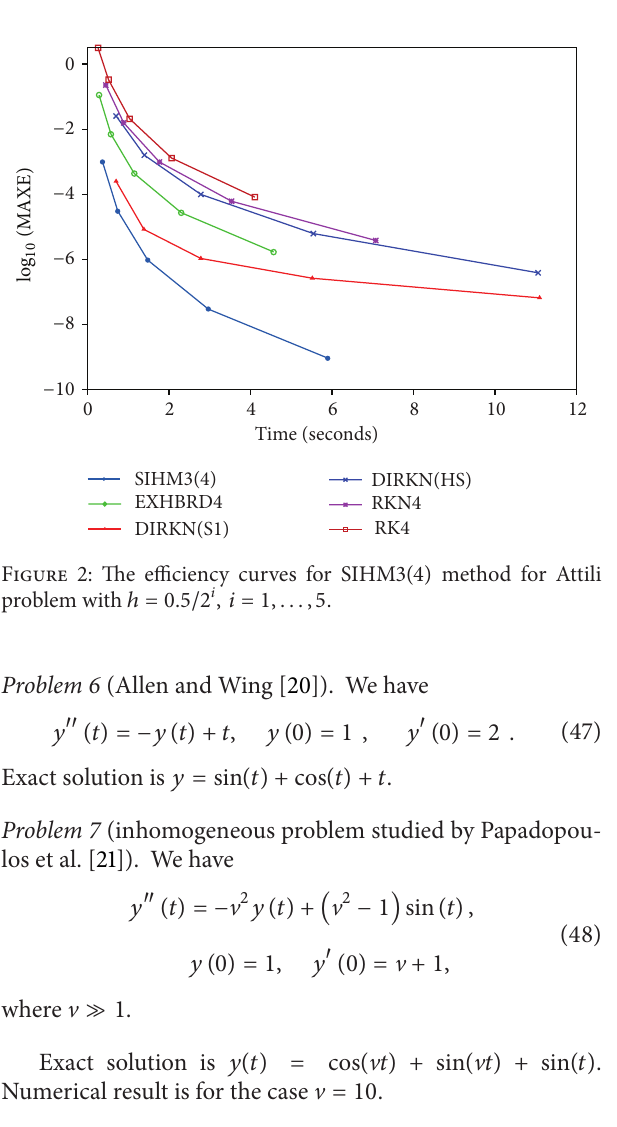
Figure 3: The efficiency curves for SIHM3 (4) method for Lambert and Watson problem with ℎ = 0.5/2 𝑖 , 𝑖 = 1,...,5 .